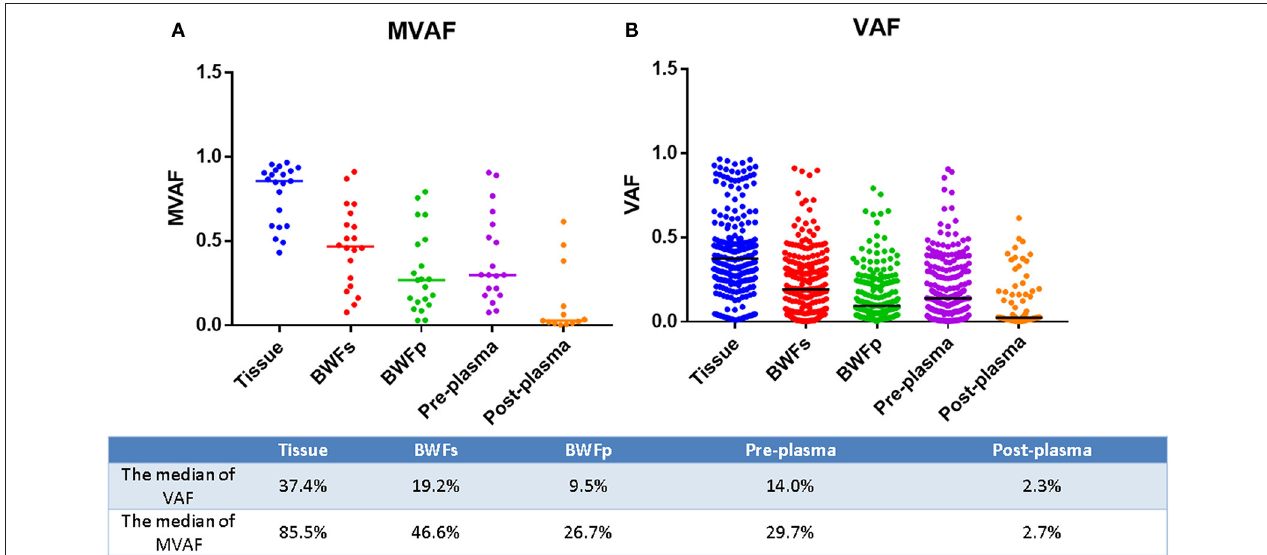
FIGURE 3 | MVAF and VAF in different sample types for each patient. (A) MVAFs of five types of samples. (B) VAFs of five types of samples.